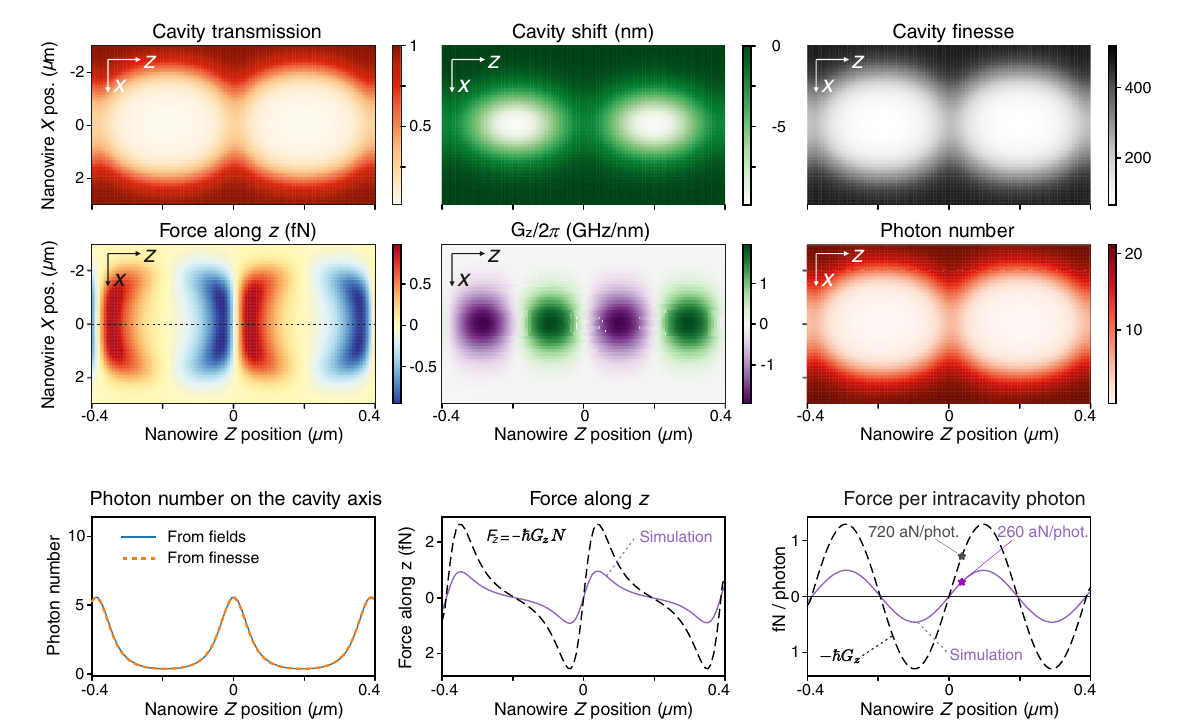
FIG. 18. Numerical simulations of the experiment. We show the results of the complete simulation [58] of the experiment, accounting for internal Mie resonances in the nanowire. We employ the following parameters: L the mirrors, 28 μ m; mirrors reflectivities, 0.994; perpendicular polarization; wavelength λ ¼ 770 nm; and input power P with perfect mode matching. The lower panels are slices taken along the optical